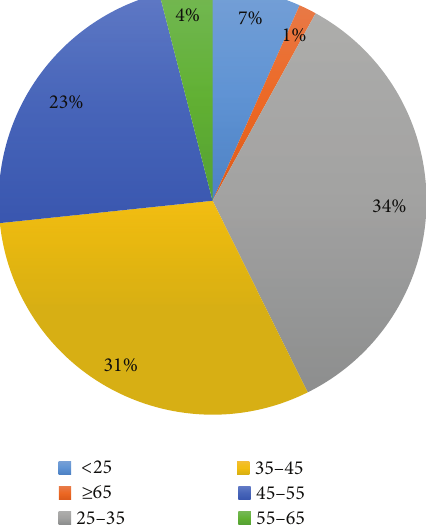
Figure 4: Educational background of e-bike riders.